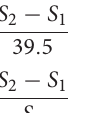
immediately after the addition of OPA. The precision is estimated as ± 4% (14 µ mol L − 1